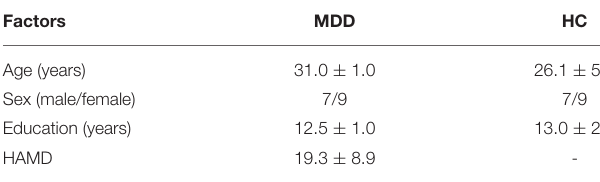
TABLE 1 | Demographic and clinical